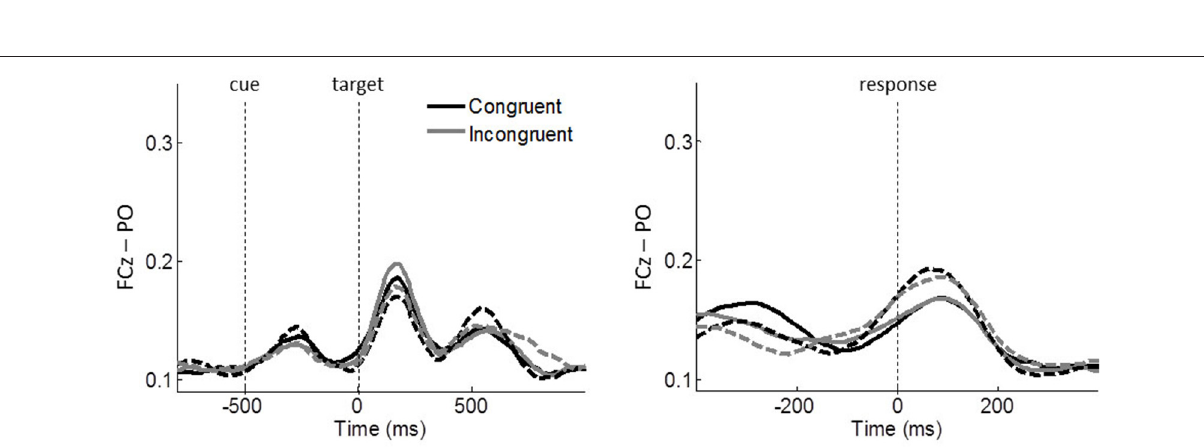
FIGURE 7 | Task-related ICPSs between FCz and PO (P5/6, P7/8, PO7/8) in theta oscillations. Stimulus-locked and response-locked ICPSs are shown on the left and right panels, respectively. Solid and dashed lines represent controls and meditators, respectively. Black and gray lines represent congruent and incongruent trials,